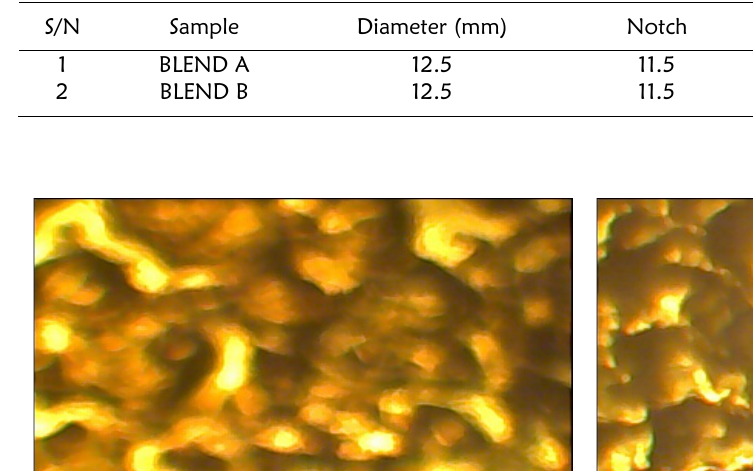
Table 5: Impact energy of the samples